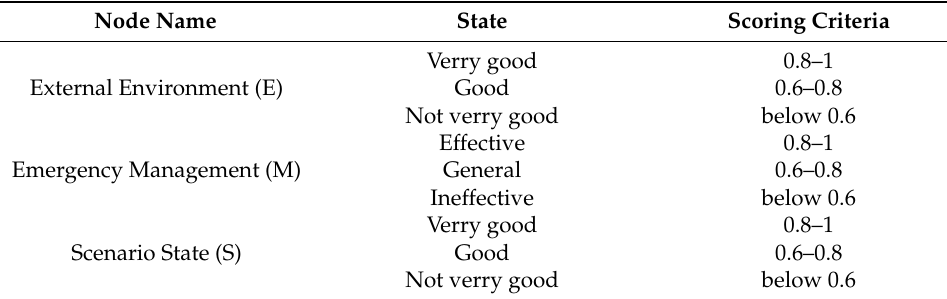
Table 5. Detailed scoring rules of network nodes.